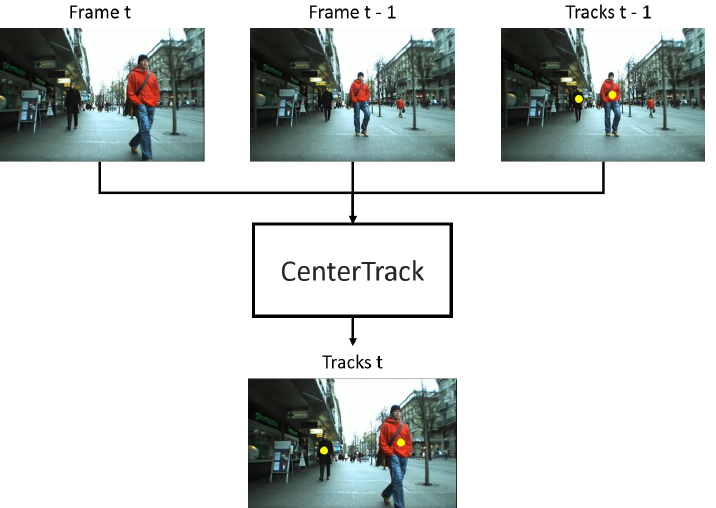
Figure 3. The point tracking approach in Ref. [46]. The current and previous frames are passed into the centerTrack network, which utilize the motion feature to detect and match